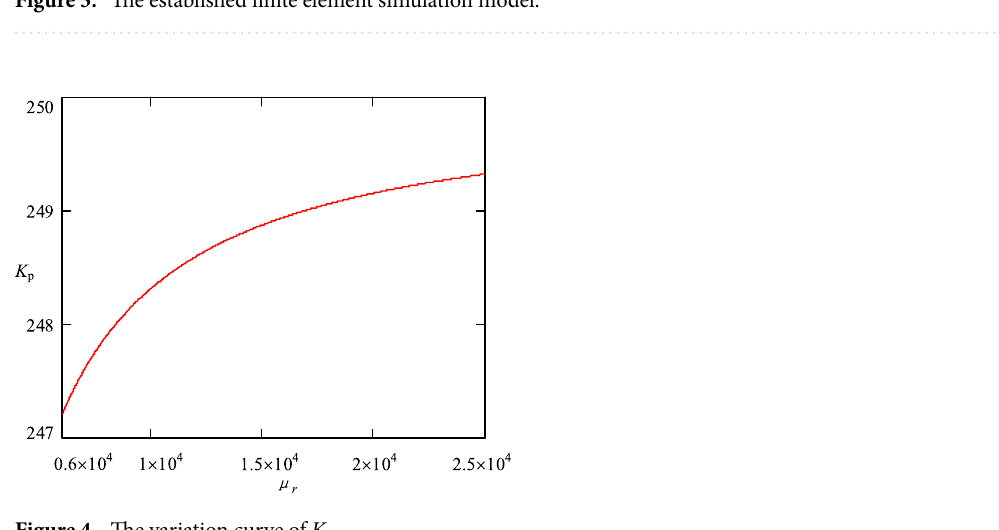
Figure 3. The established finite element simulation model.